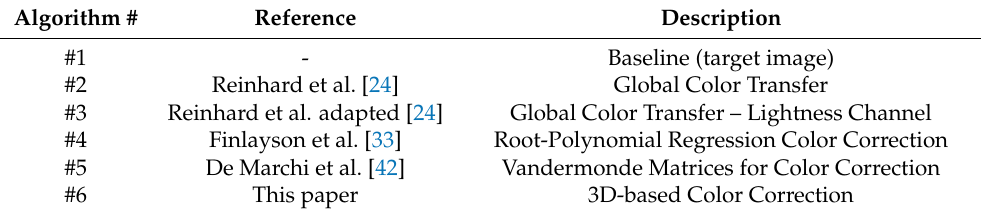
Table 1. Algorithms compared with the proposed